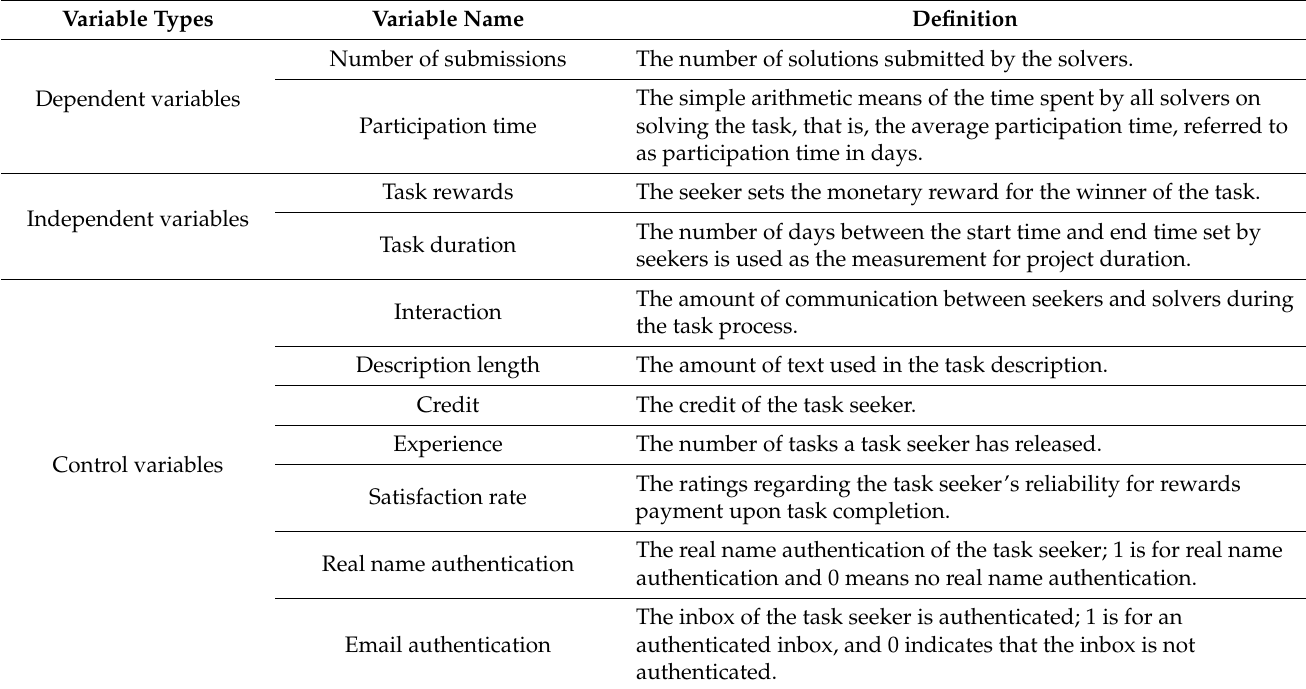
Table 2. Description of the definitions of the main model